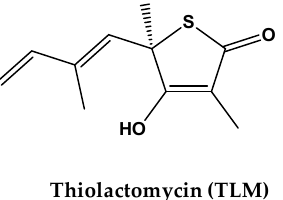
Figure 4. Chemical structure of the co-crystal ligand thiolactomycin (TLM) of β -ketoacyl ACP synthase I (KasA).